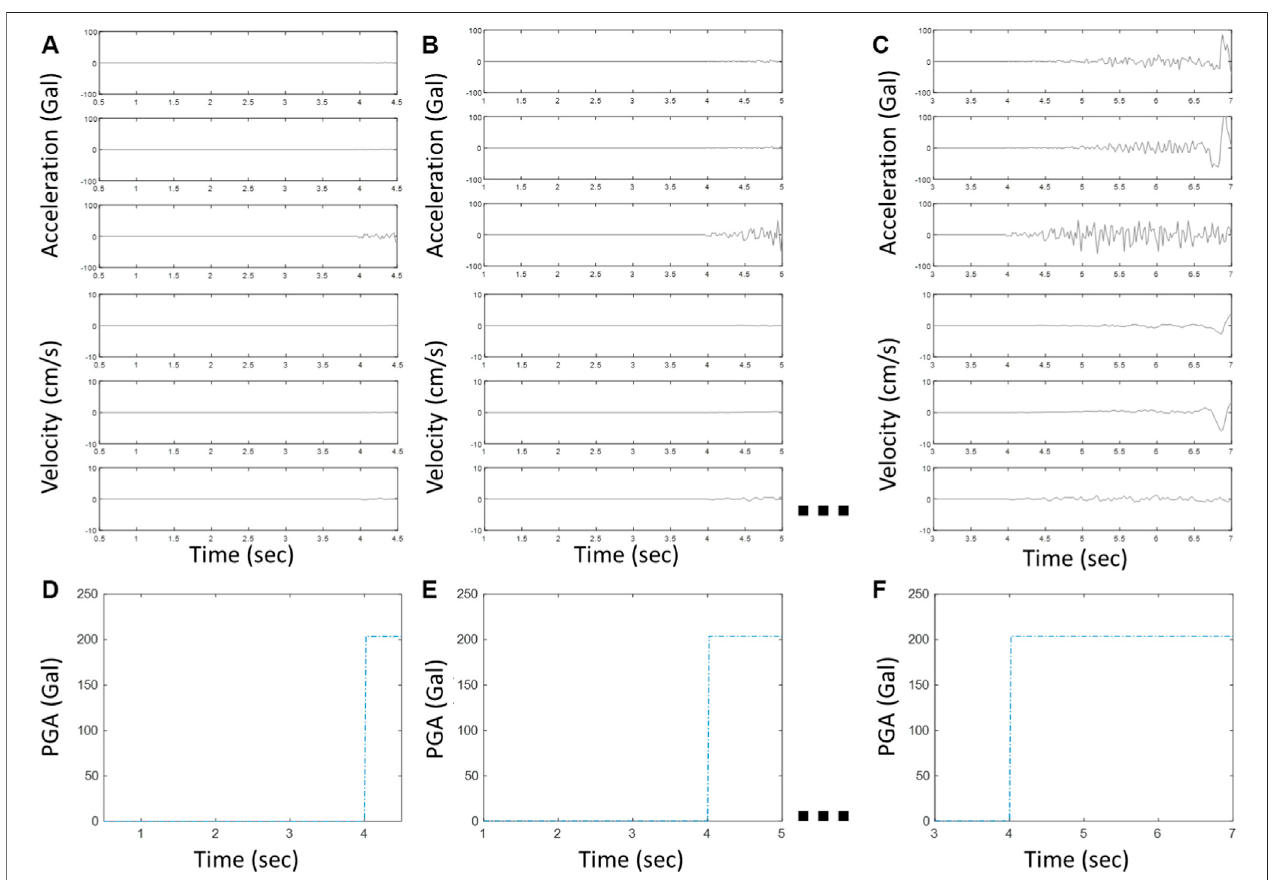
FIGURE 3 | A typical example of the input/output of the LSTM model. (A) input of t w = 0.5 s; (B) input of t w = 1.0 s; (C) input of t w = 3.0 s; (D) target output of t w = 0.5 s; (E) target output of t w = 1.0 s; and (F) target output of t w = 3.0 s.